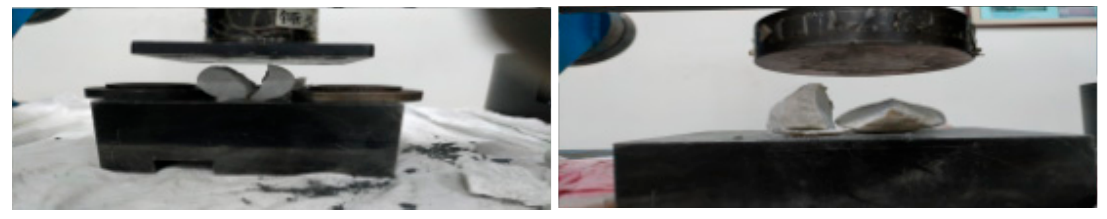
Figure 8. Photo of the crushing test on a white marble particle from the feed sample.